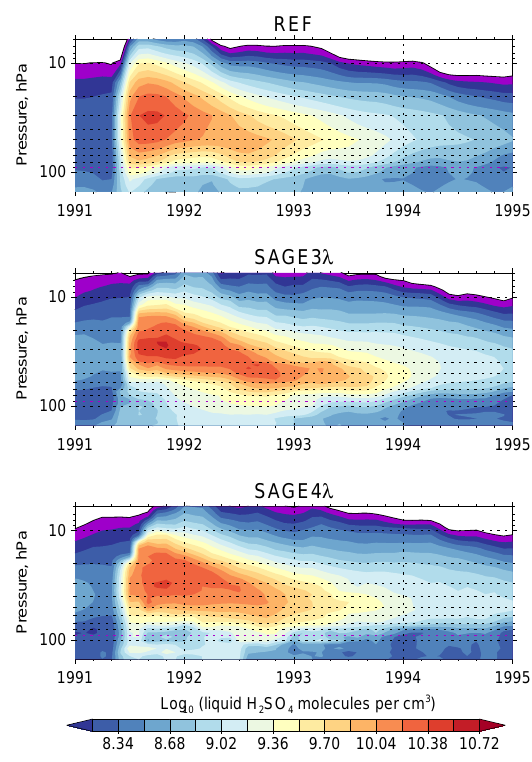
Figure 7. Vertical distribution of liquid H 2 SO 4 concentration aver- aged over the tropics (20 ◦ S–20 ◦